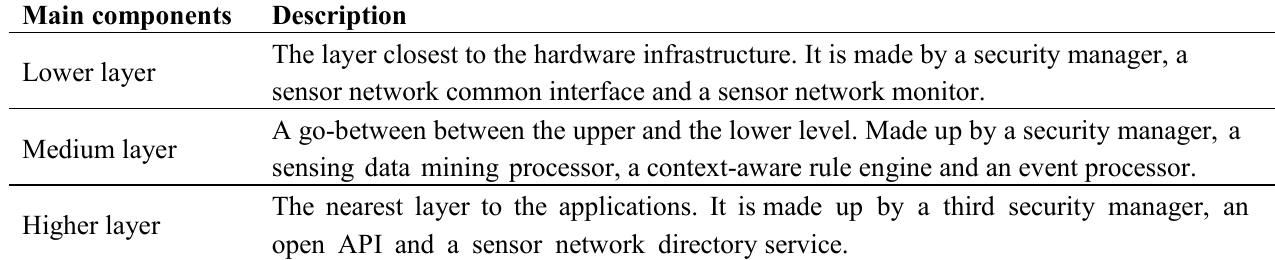
Table 3. Description of Ubiquitous Sensor Network middleware